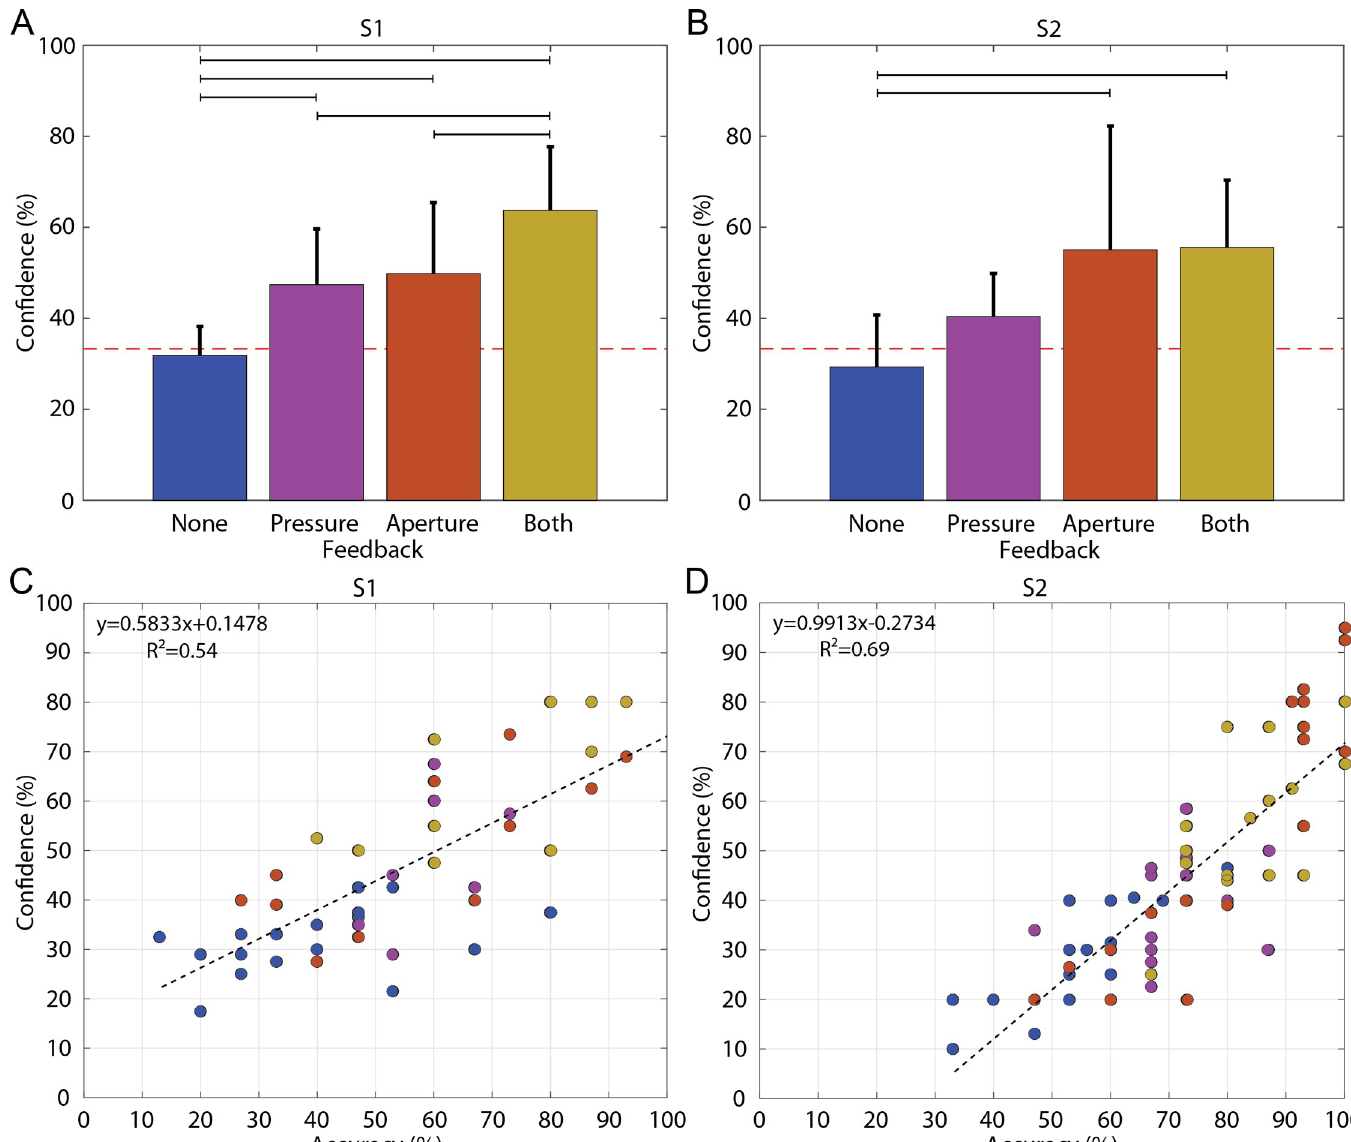
Fig 6. Average confidence levels for S1 (A) and S2 (B) as a function of feedback type. Confidence increased with addition of feedback. There was a significant positive correlation between subject confidence and subject accuracy even though the subject was blinded to results (C and D). Colors indicate the feedback